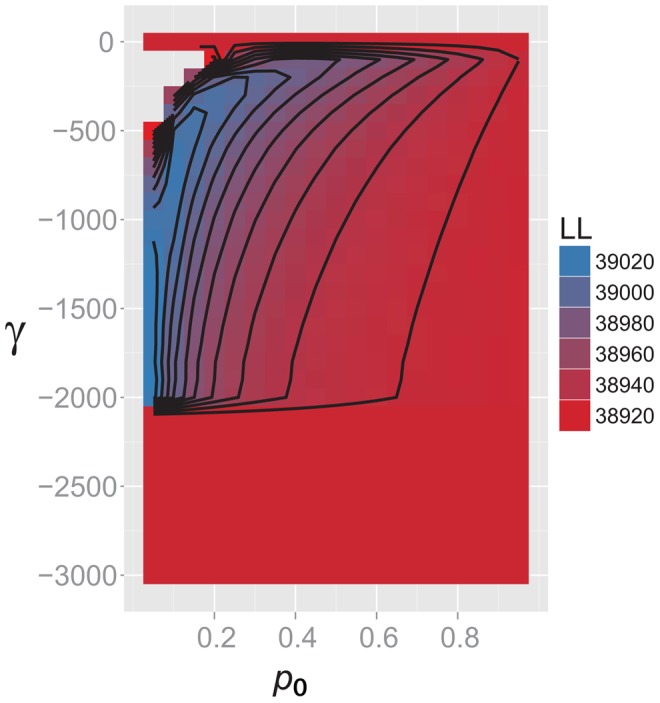
Heatmap of likelihoods: inference of selection.Heatmap of likelihood values over a grid of parameter values for neutral plus selected sites model. The proportion of neutral sites (p0) is shown on the X axis; the composite parameter γ (2Nes) is shown on the Y axis. There is a steep ridge of likelihoods at low values of p0.